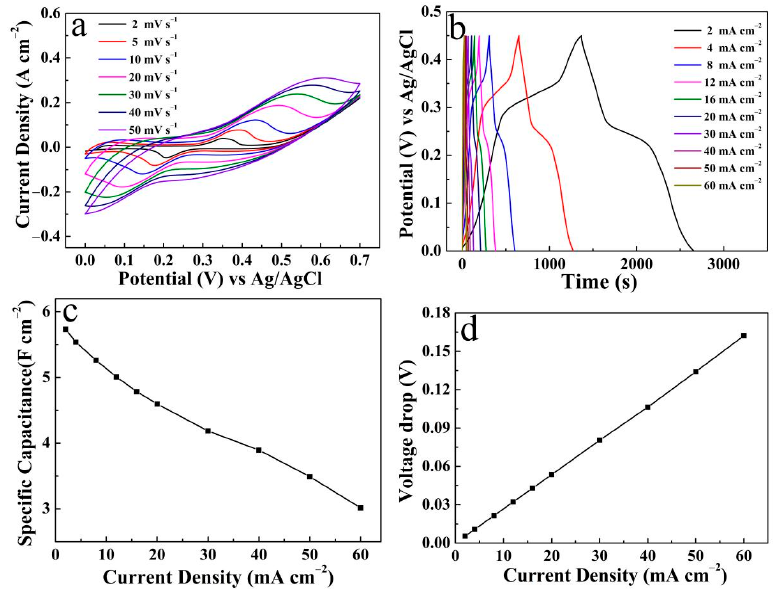
Figure 7. ( a ) CV curves, ( b ) GCD curves, ( c ) Cs and ( d ) voltage drops at different current densities of Co(OH) 2 /Ni 3 S 2 heterostructure (S-20). As for single-component Co(OH) 2 and Ni 3 S 2 electrodes, their CV curves at scan rates of 2–50 mV s − 1 , GCD curves at current densities of 2–60 mA cm − 2 and the corresponding C s are also presented in Figure 8.